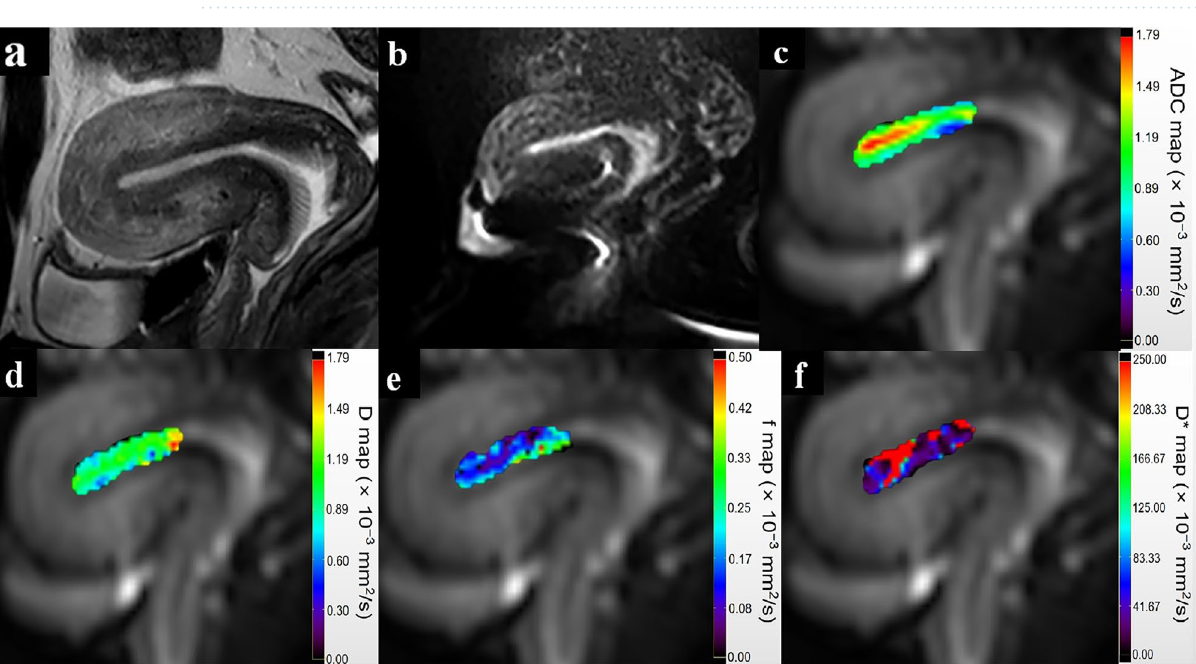
Figure 3. A 33-year-old patient with hysteroscopy confirmed endometrial fibrosis. ( a ) Sagittal T2-weighted turbo spin-echo (TSE) image reveals a thin ribbon-shaped endometrium with multiple cysts in the cervix. ( b ) Sagittal diffusion-weighted image (b = 800 s/mm 2 ) of the uterus depicts the high signal intensity endometrium. Parametric maps of ADC ( c ), D ( d ), f (e) and D* ( f ) demonstrate that the average ADC, D , f and D* values of the fibrous endometrium are 1.0 × 10 −3 mm 2 /s, 0.90 × 10 −3 mm 2 /s, 0.10 and 34.46 × 10 −3 mm 2 /s, respectively. ADC apparent diffusion coefficient, D true diffusion coefficient, f perfusion fraction, D* pseudodiffusion